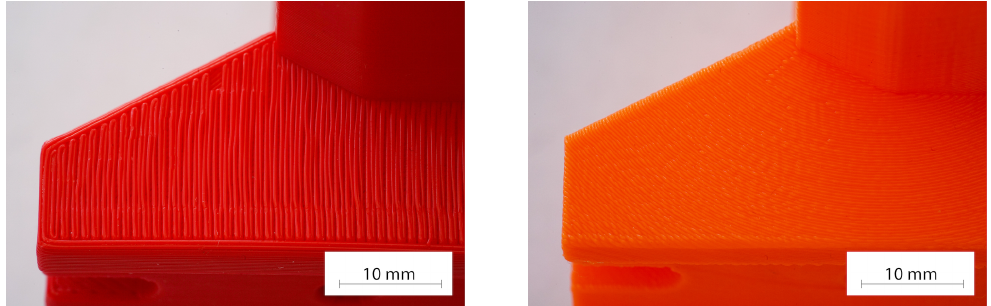
Figure 19. Horizontal, downward 90° overhang printed on a Prusa Mk3s ( red , with support) and the RotBot ( orange , without support).